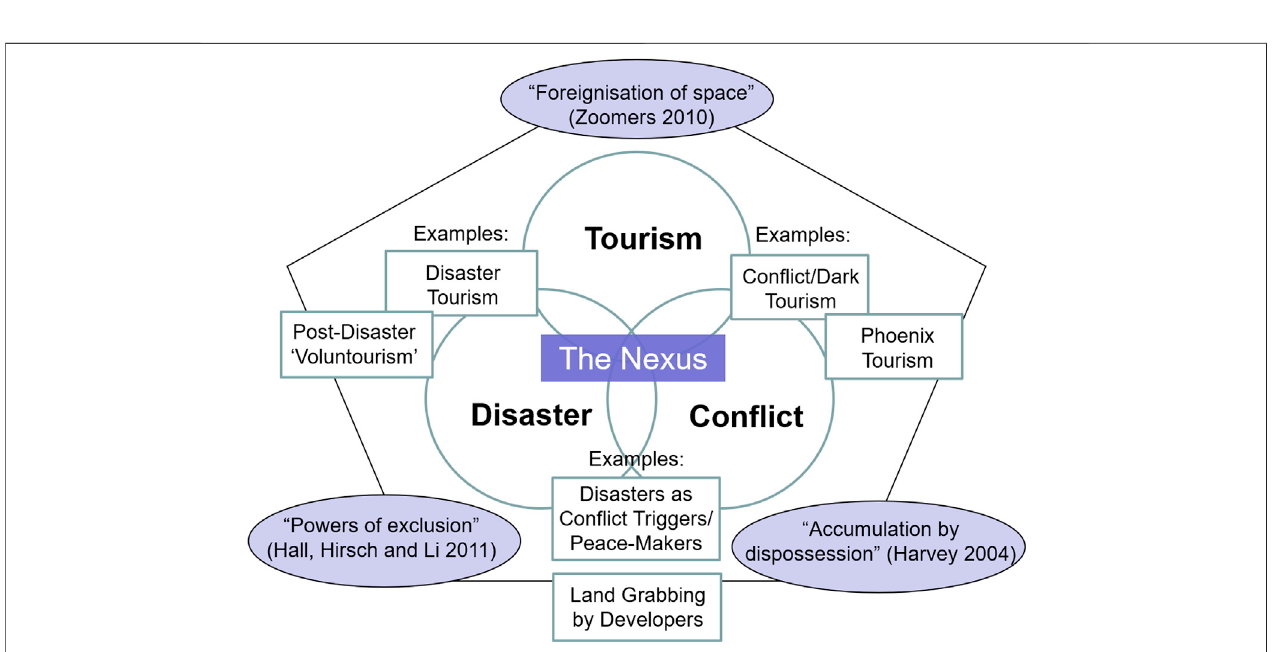
FIGURE 3 | The tourism-disaster-con fl ict nexus and underlying concepts and theoretical frameworks. Source: Author ’ s own.